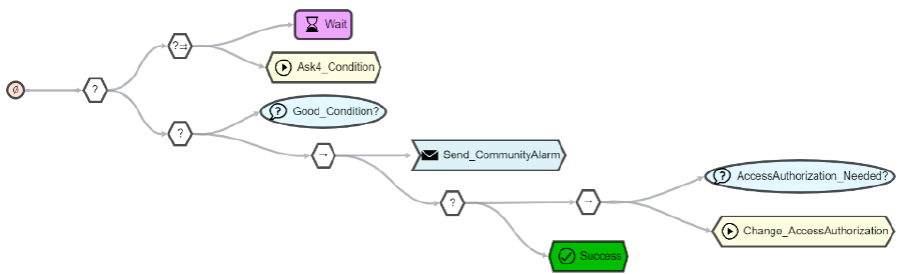
Figure 14. SBT for the user and community platform